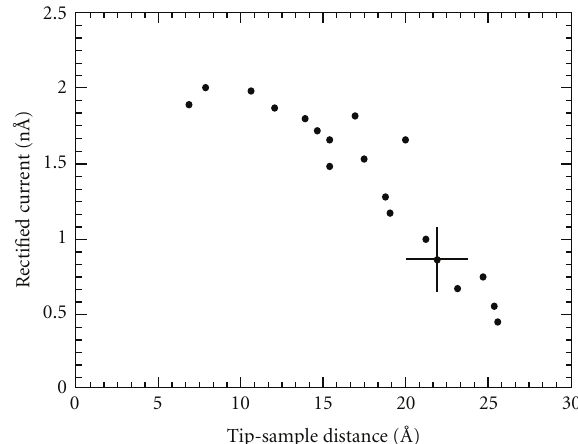
Figure 10: The measured rectified current is shown as a function of tip-sample distance for λ laser = 1 . 06 μ m. Cross-hair indicates estimated uncertainties in measurements [12].